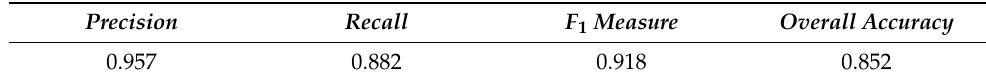
Table 3. Result of model performance obtained from confusion matrix.